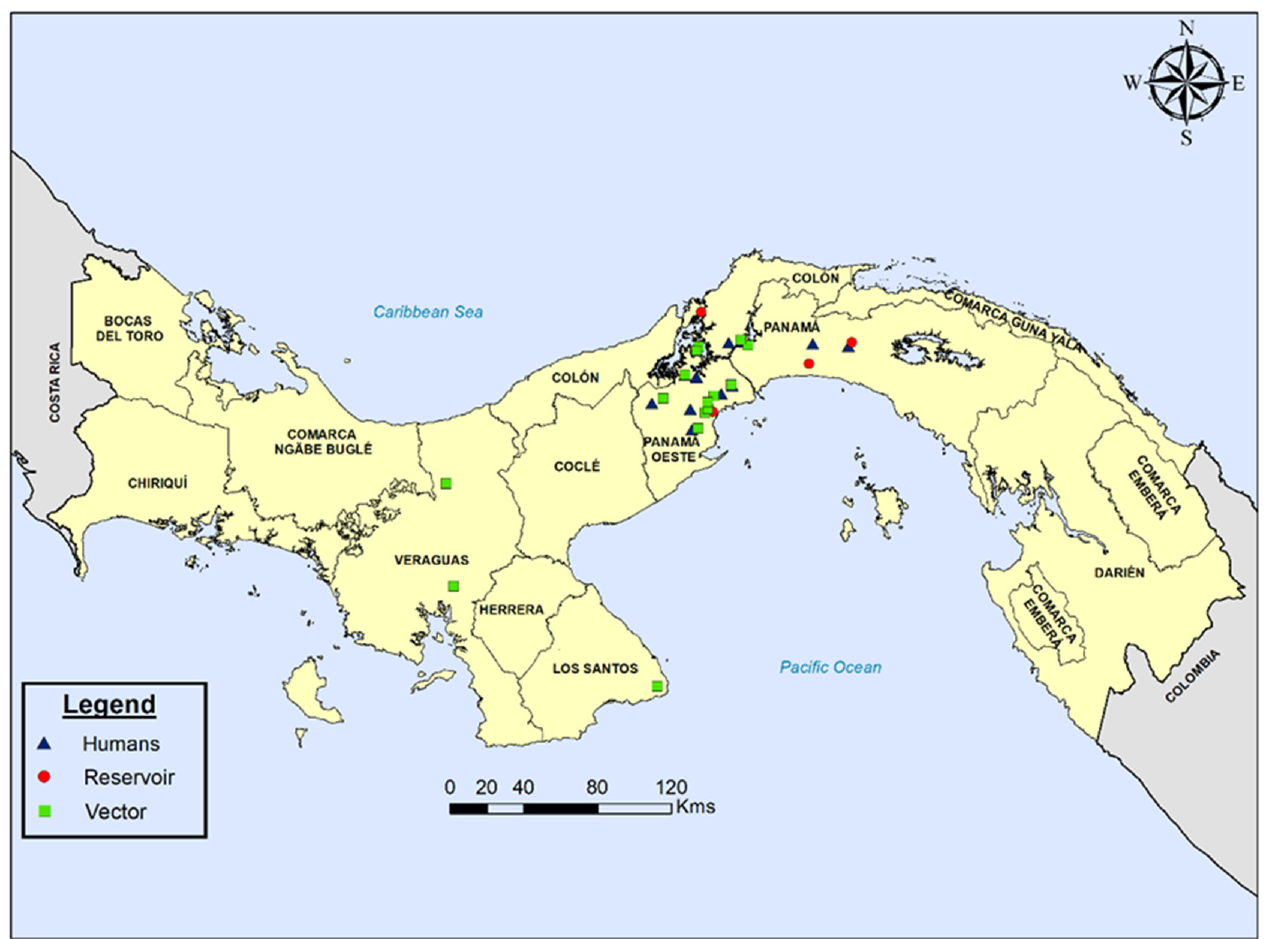
Figure 1. Map of Panama showing the geographical origin and biological source of the 32 Panamanian Trypanosoma cruzi isolates analyzed in this study. Blue triangles represent samples isolated from humans, red circles from reservoirs and green squares from vectors.